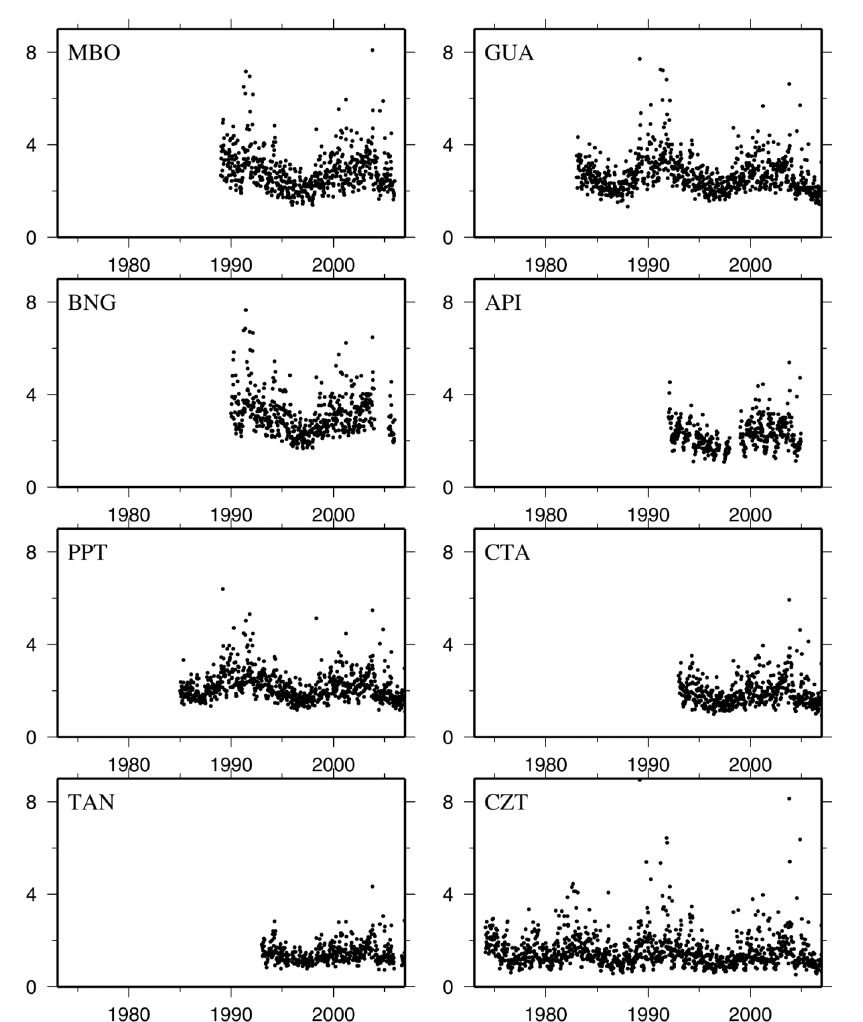
Fig. 8. Ten-day means of hourly standard deviations of F ( µ T) for observatories outside SAA. Observatories organised by |inclination| from left to right, top to